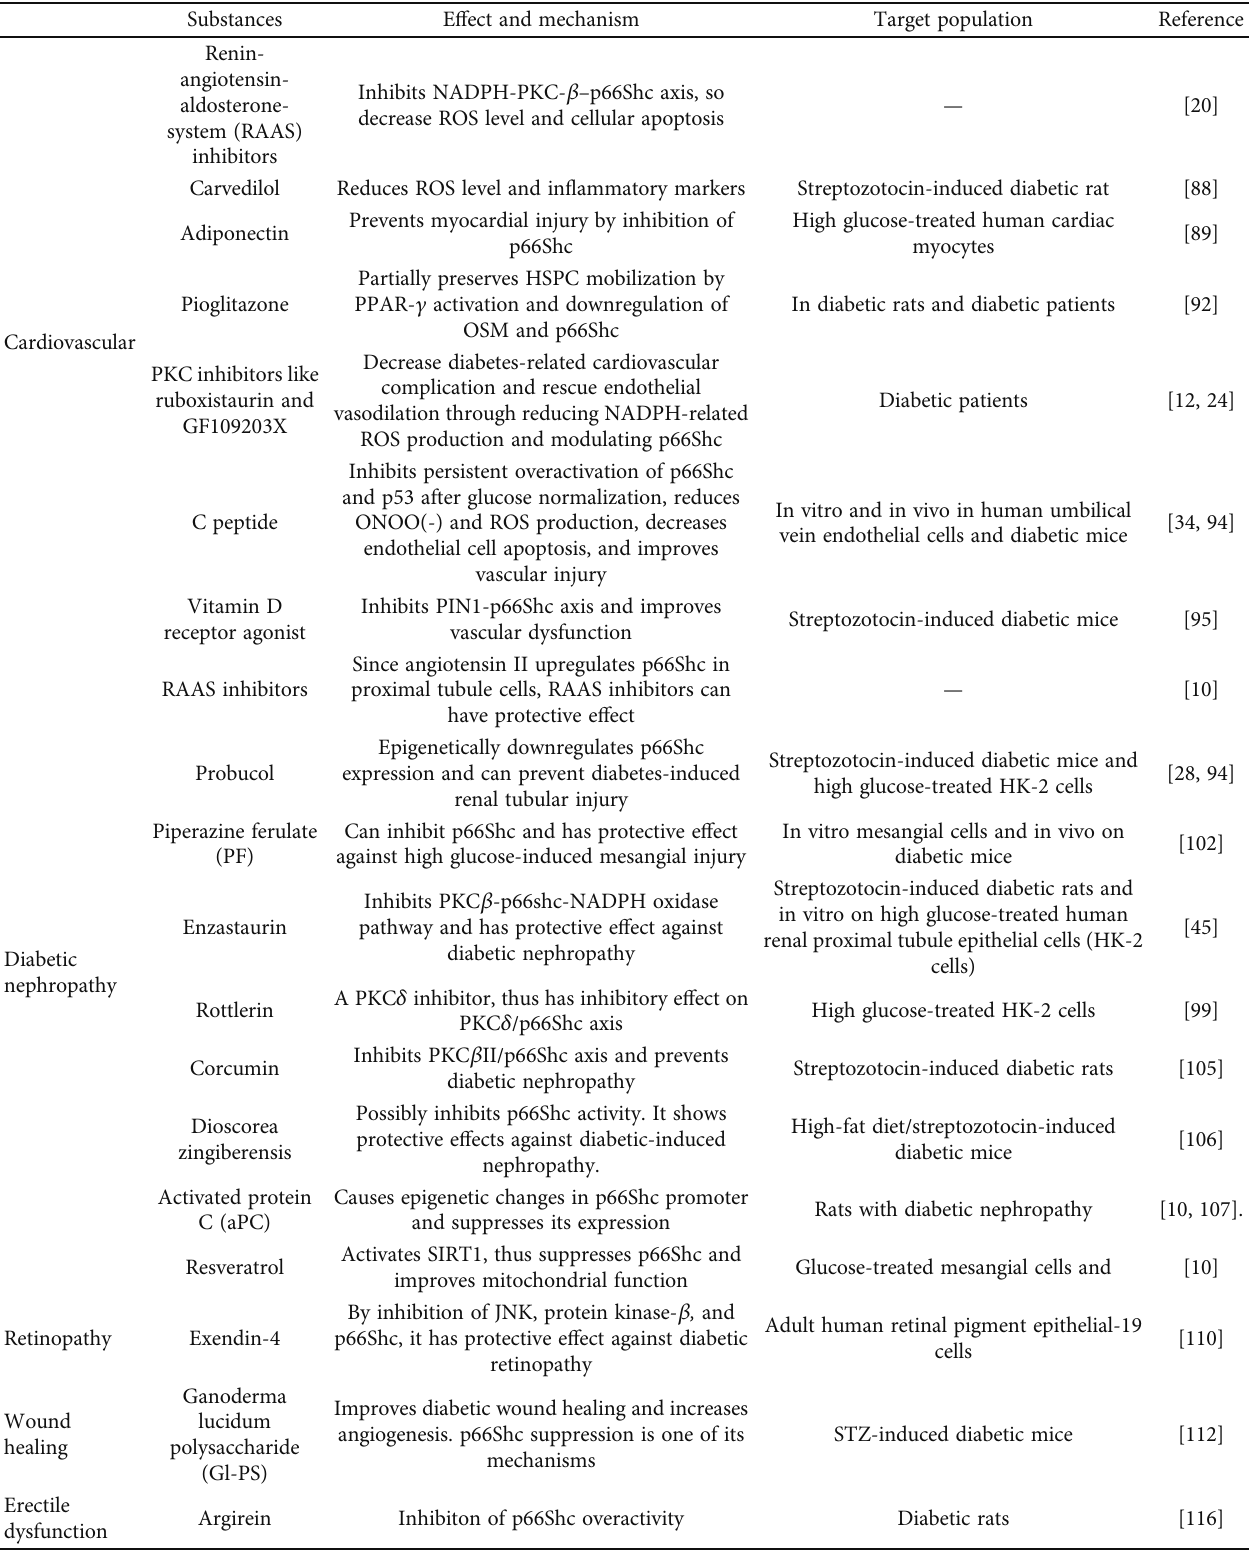
Table 1: Substances which show bene fi t against diabetes-related complication. Of note, more investigations are needed, and until today, there is not enough evidence to support the actual e ff ect of these